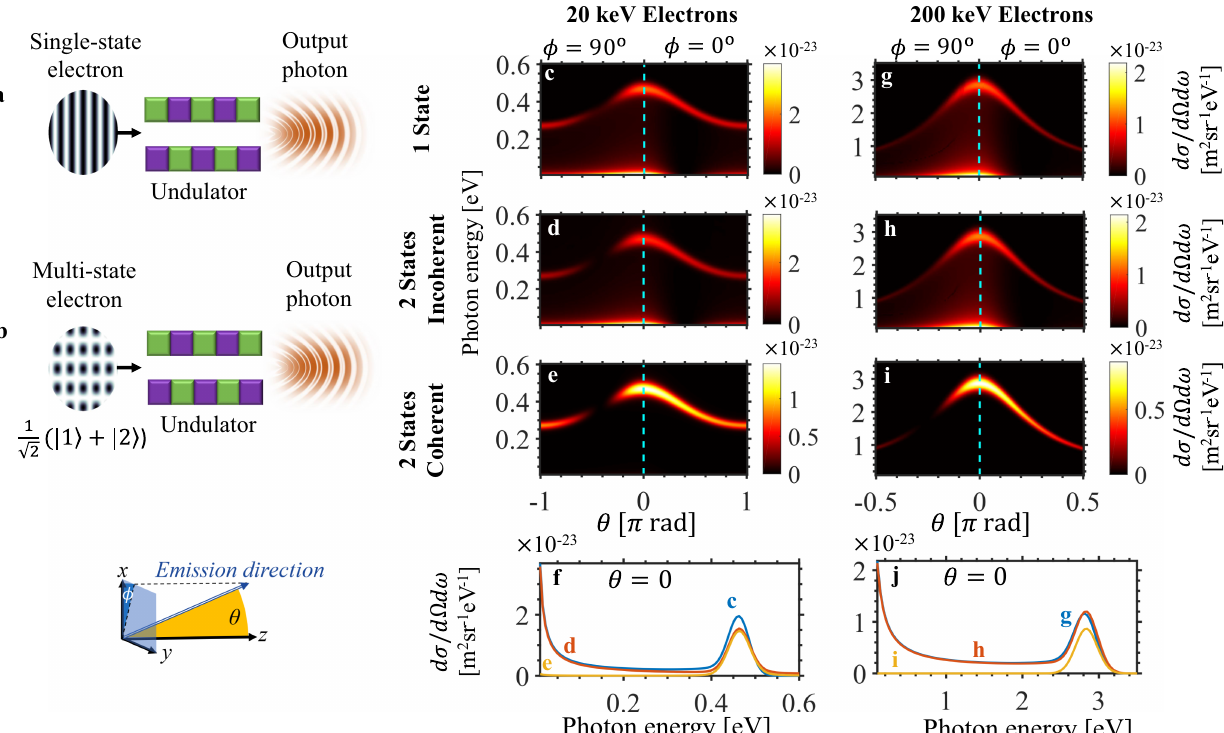
Fig. 3 Enhanced monochromaticity of magnetic bremsstrahlung (undulator radiation) through shaped electron wavepackets. We consider the scattering of an input electron off the magnetic fi eld of a nano-undulator, for the case of a single momentum state input electron ( a ) and that of an input electron made up of two states 1 j i and 2 j i ( b ). c shows the differential cross section d σ = d Ω d ω of the emission process for the single-state input electron scenario in ( a ). In addition to a relatively monochromatic peak, there is a strong synchrotron-radiation-like signature leading to relatively broadband radiation, with signi fi cant radiation components at lower photon energies. d and e show the emission patterns for the double-state input electron scenario in ( b ), with incoherent and coherent processes considered in ( d ) and ( e ), respectively. As e shows, the quantum coherence leads to destructive interference that strongly suppresses the broad synchrotron peak at low photon energies, leading to a more monochromatic output in a given direction. Cross sections of the emission patterns at θ = 0 are compared in ( f ). The suppression of low photon energies continues to hold at other choices of electron energies, as shown in g – j , which presents the emission spectra for electrons of 200 keV, corresponding to the scenarios in c – f . The undulator considered is ¼ ± 0 : 5 o with respect to the z - of period 1 μ m and has an effective length of 5.3 μ m. The two input electron states are of opposite phase and oriented at θ 1 ; 2 axis in d and e , and at θ 1 ; 2 ¼ ± 0 : 025 o in h and i